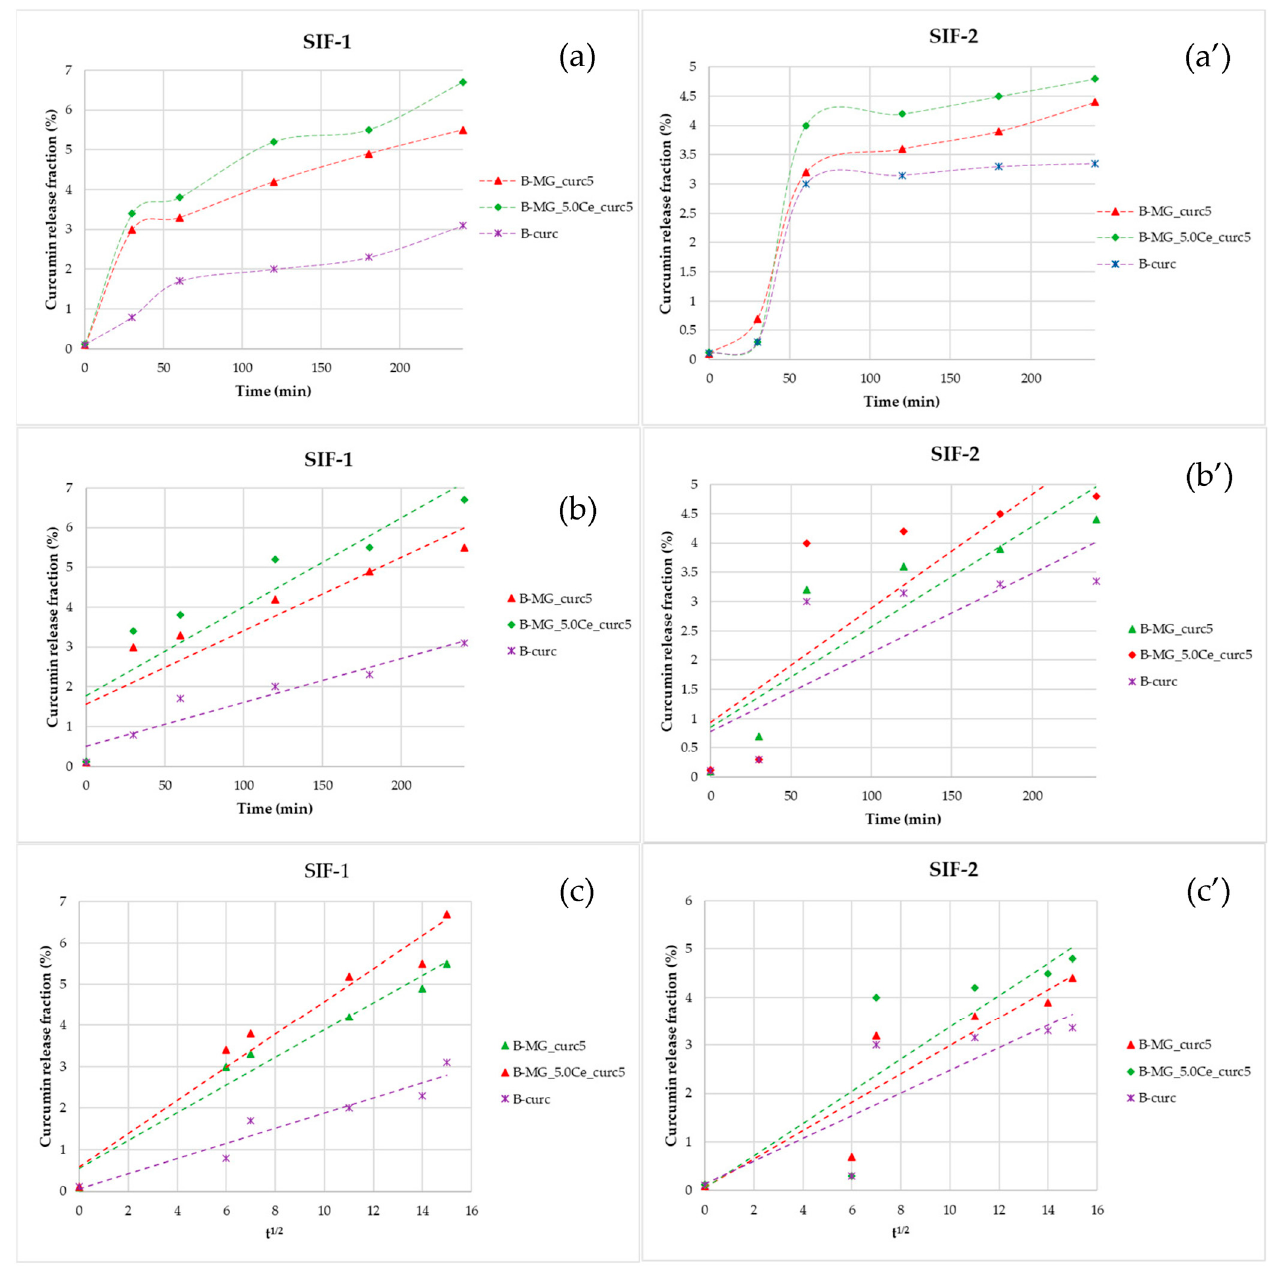
Figure 8. Representations of the kinetics release of the beads in SIF. ( a , a’ ) Percentage fraction of time-released curcumin; ( b , b’ ) linearization according to Peppas’ model; and ( c , c’ ) linearization according to Higuchi’s model.